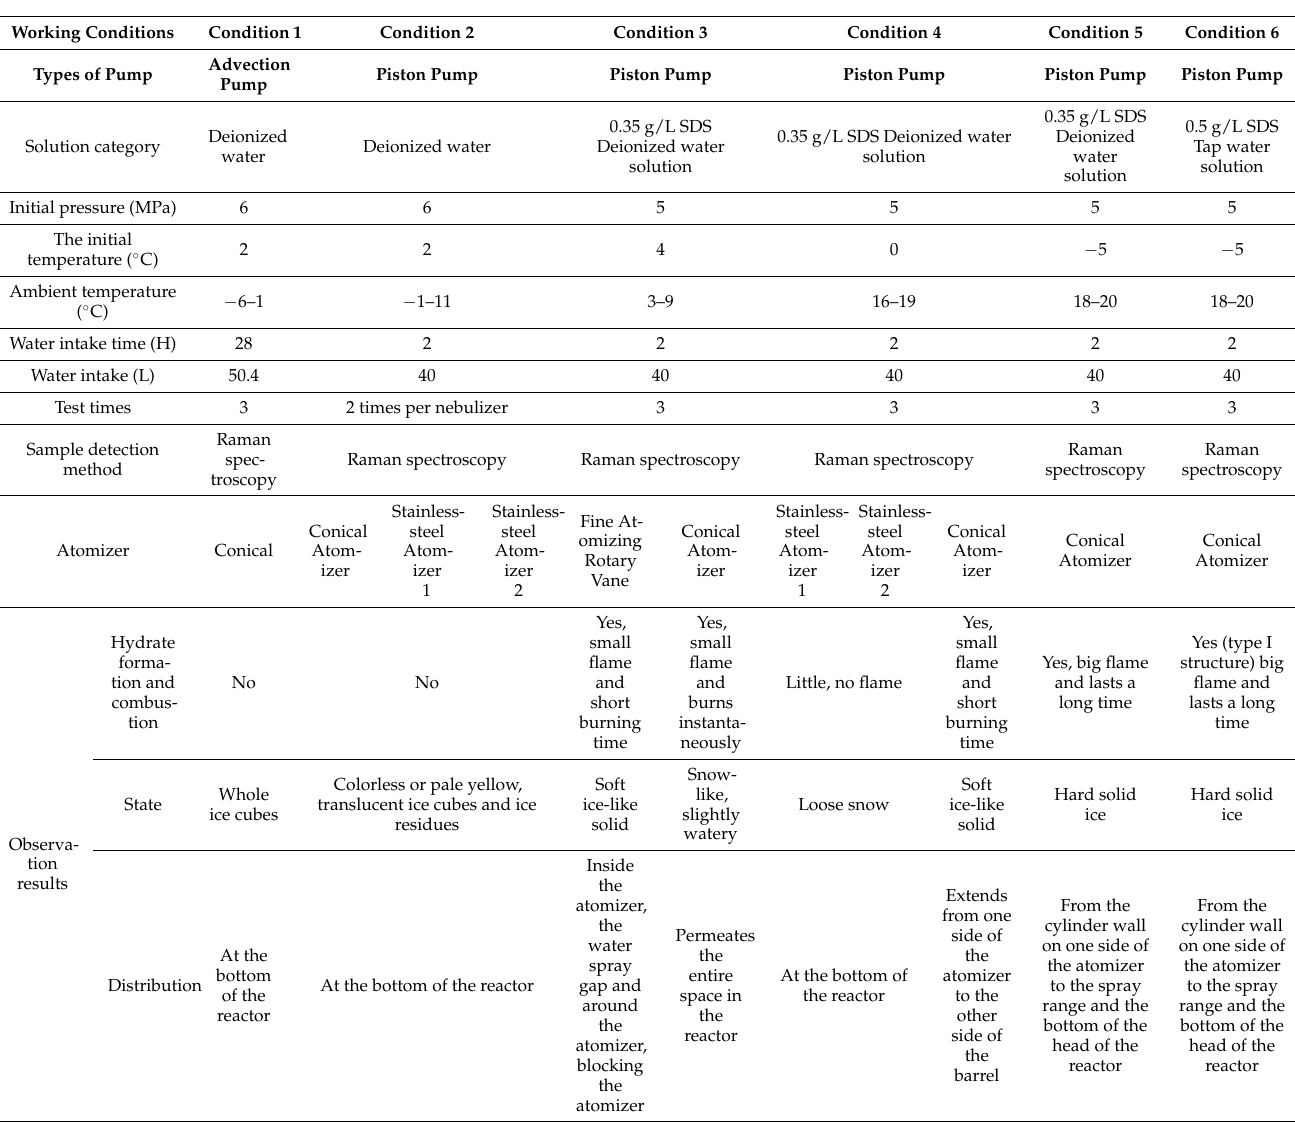
Table 4. Experimental conditions and